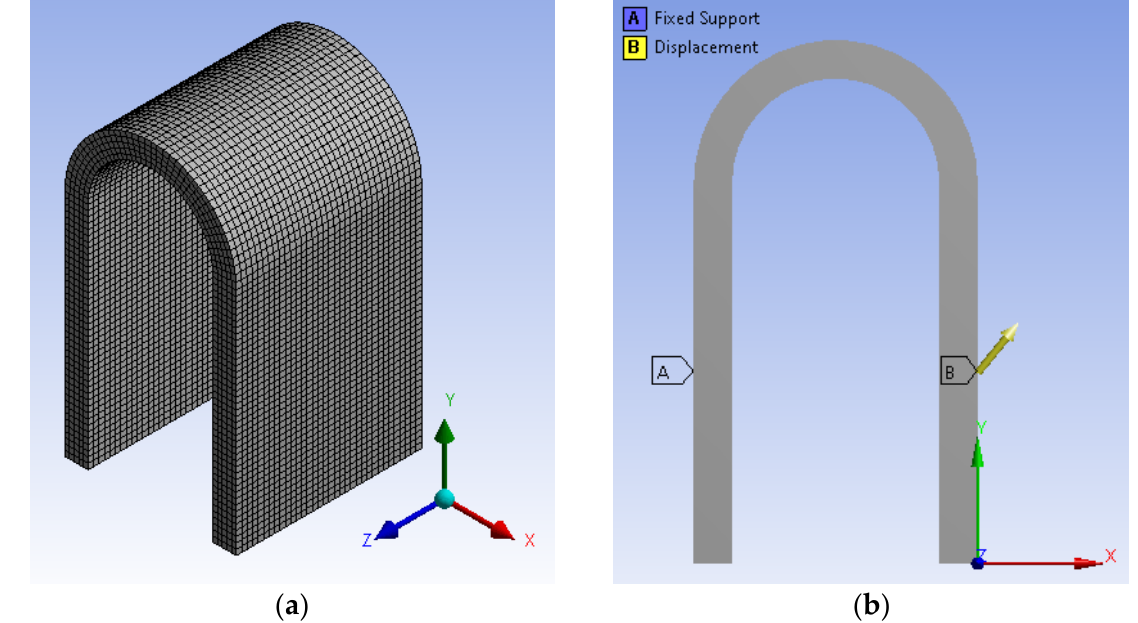
Figure 2. Finite elements model in ANSYS workbench: ( a ) meshed shape; ( b ) boundary condition.